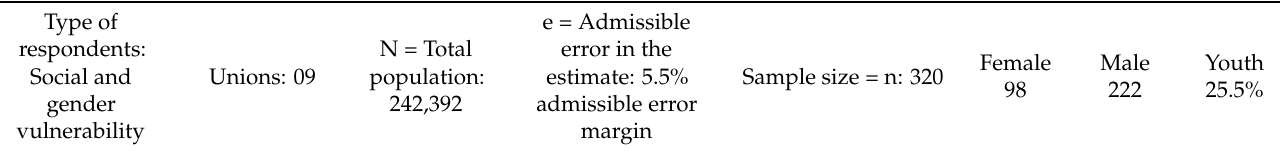
Table 3. Detail of quantitative sample size